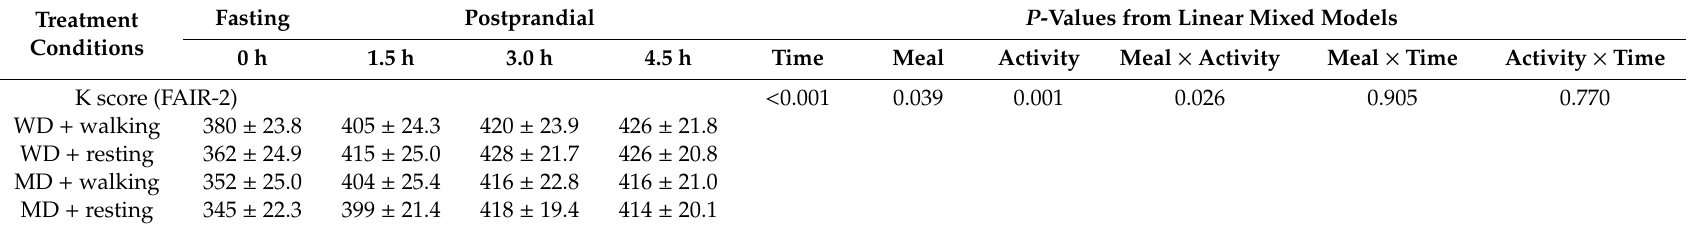
Table 3. Fasting and postprandial attention (FAIR-2, K score) 1,2 .